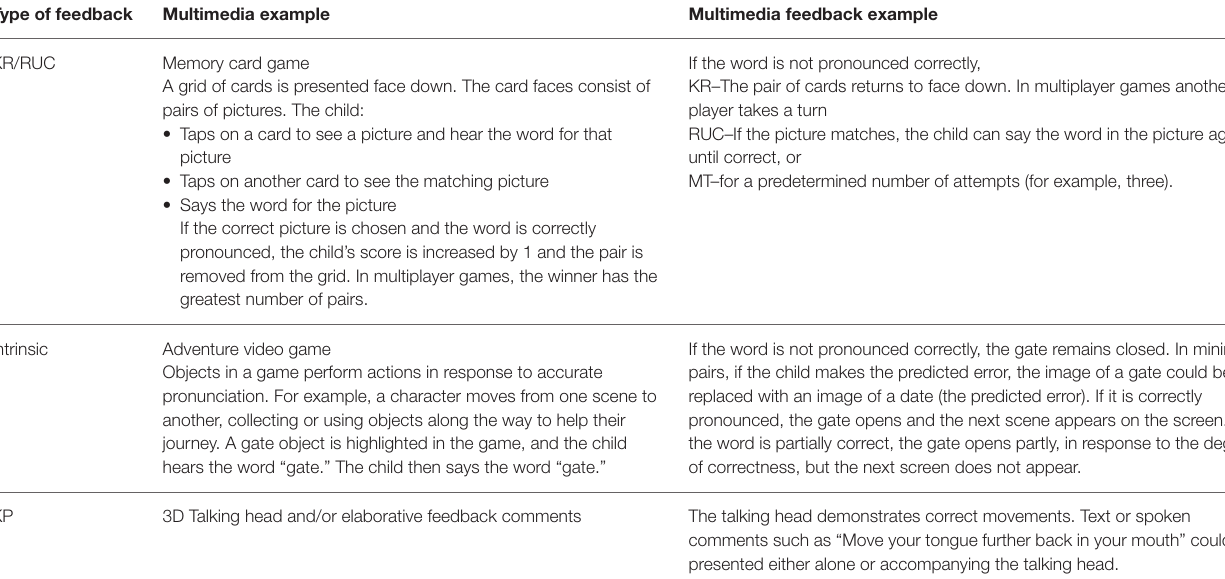
TABLE 2 | Examples of implementation in multimedia for common types of